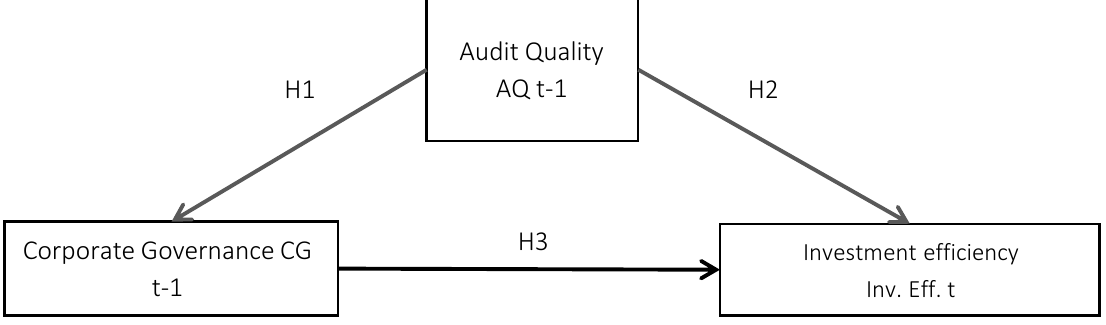
Figure 1. Research model to test